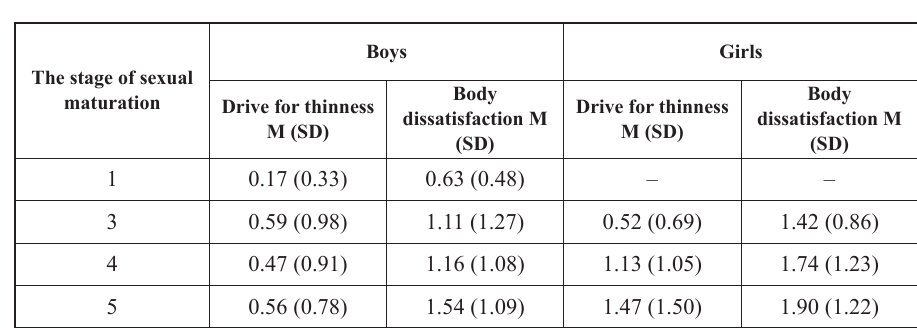
The stage of sexual maturation